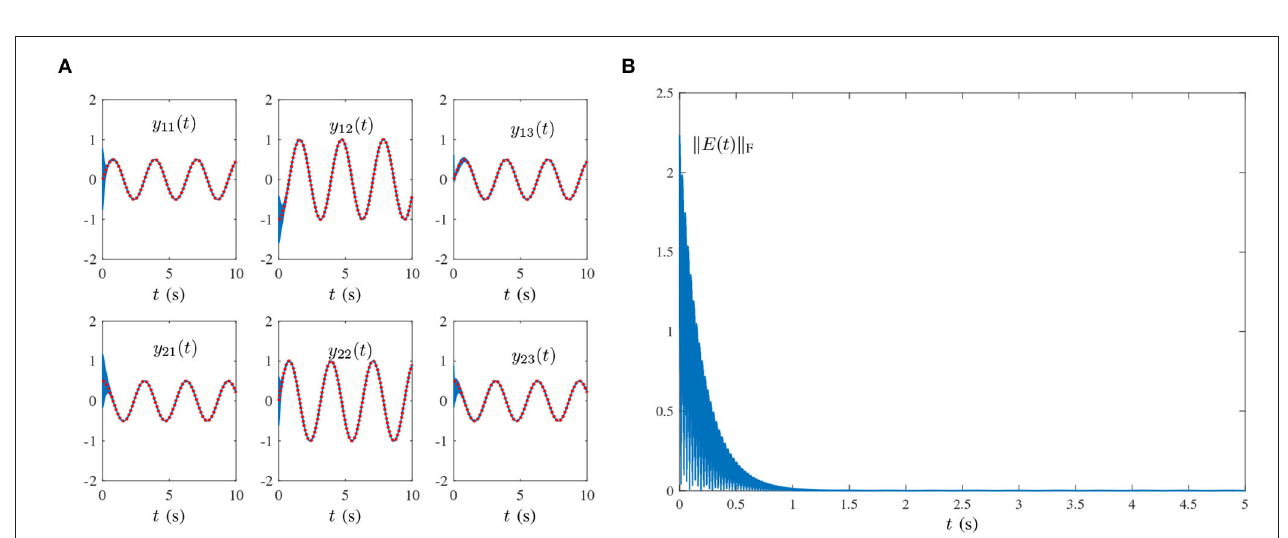
FIGURE 5 | Results synthesized by the HNTZNN model (14) using τ = 10 and λ = 1 for computing the pseudoinverse of the dynamic matrix (21) under the multiple-harmonic noise with a periodic characteristic. (A) State trajectory. (B) Residual